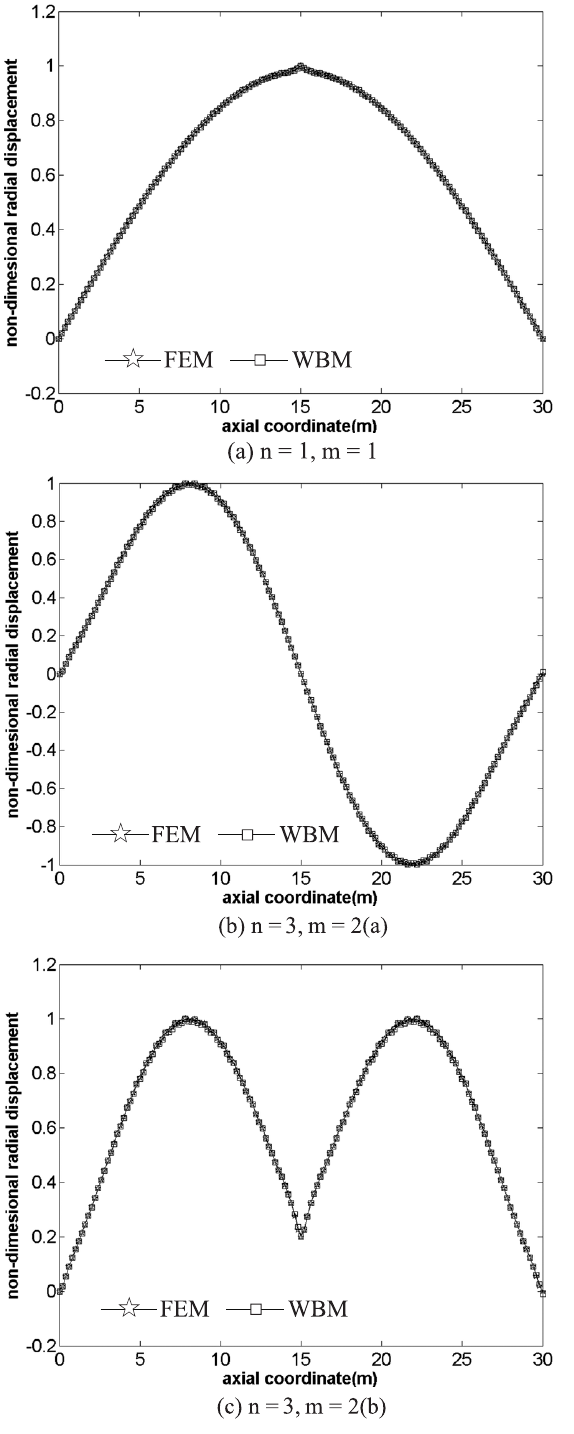
Fig. 12. Comparison of vibration mode shapes of model M2 calcu- lated by FEM and WBM for F-F boundary